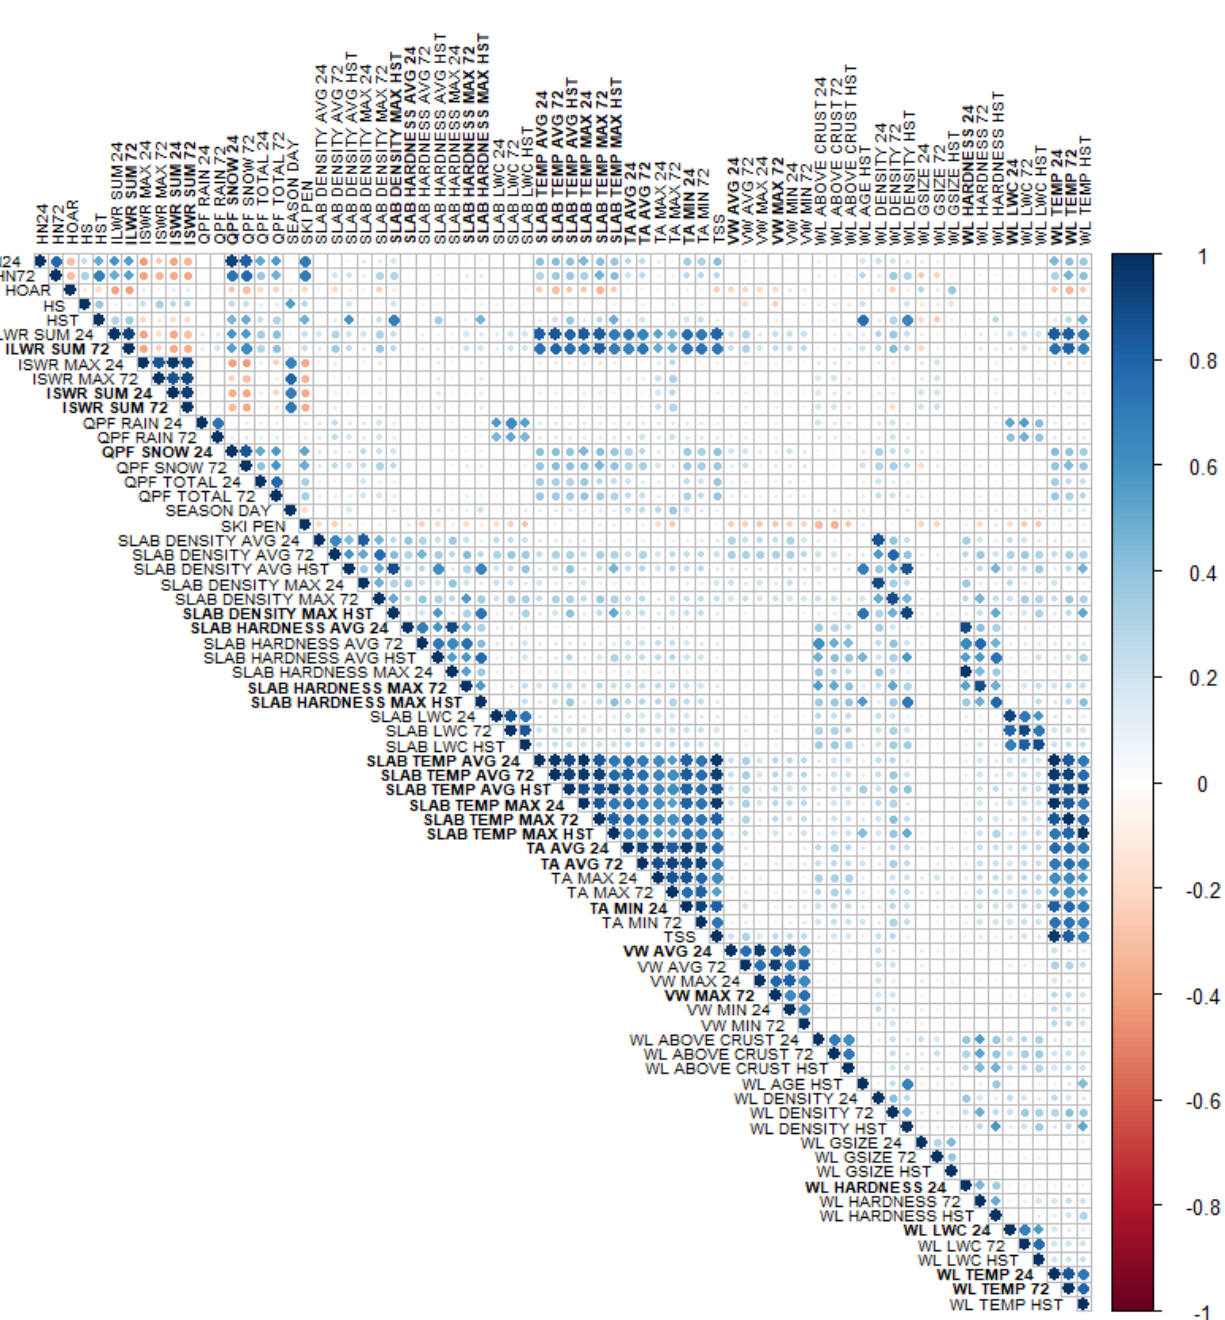
Figure B1. Correlation matrix for weather and snowpack variables used in decision trees for surface avalanche problems. Variables in bold were removed due to high correlation with other variables. Variable names are described in Tables 2, 3, and